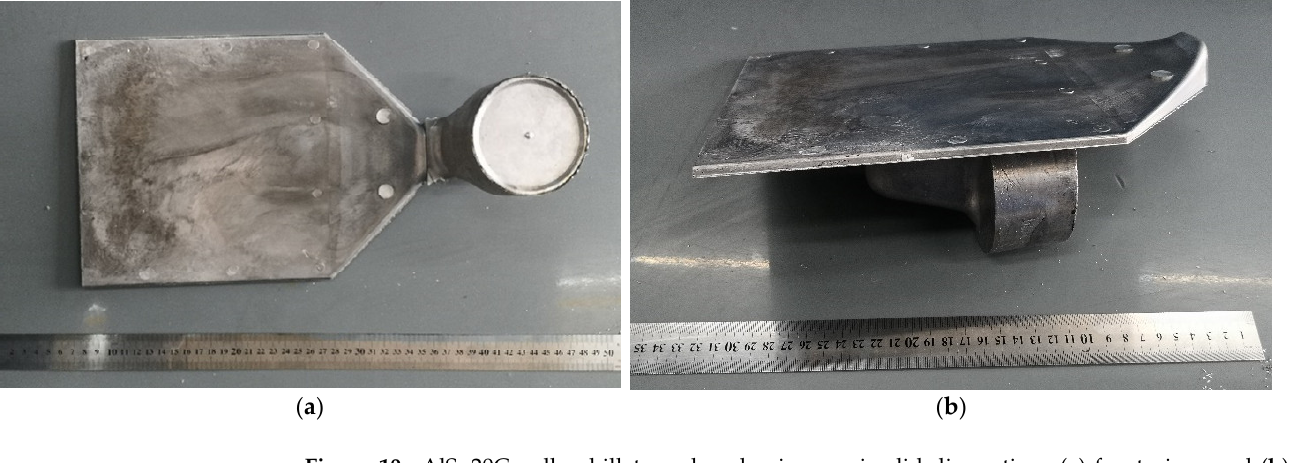
Figure 9. Scanning electron microscope (SEM) images of the final milled sheet: ( a ) S-T direction, and ( b ) L-S direction.